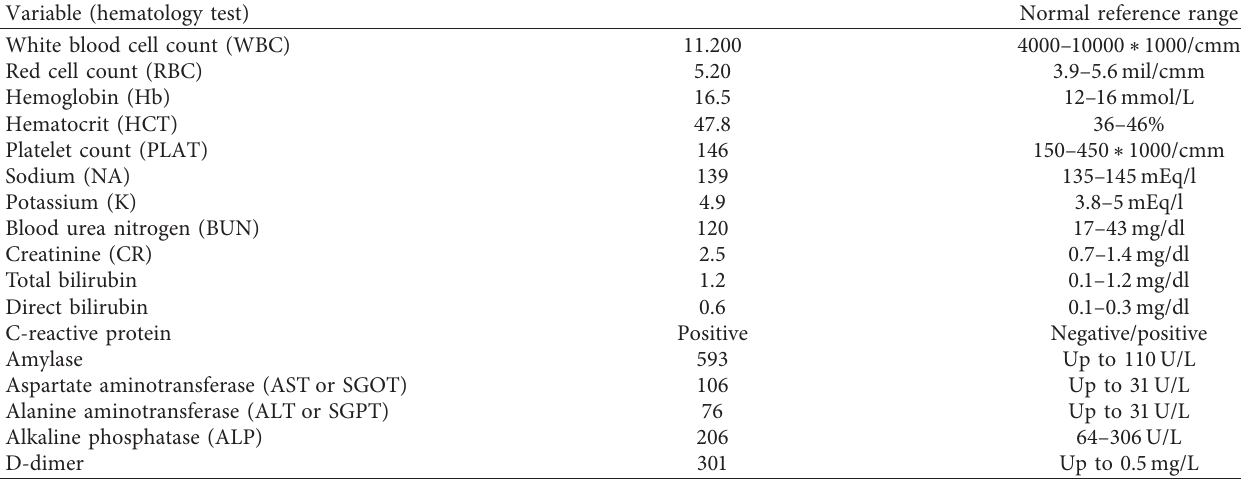
Table 1: The laboratory findings of the patient.